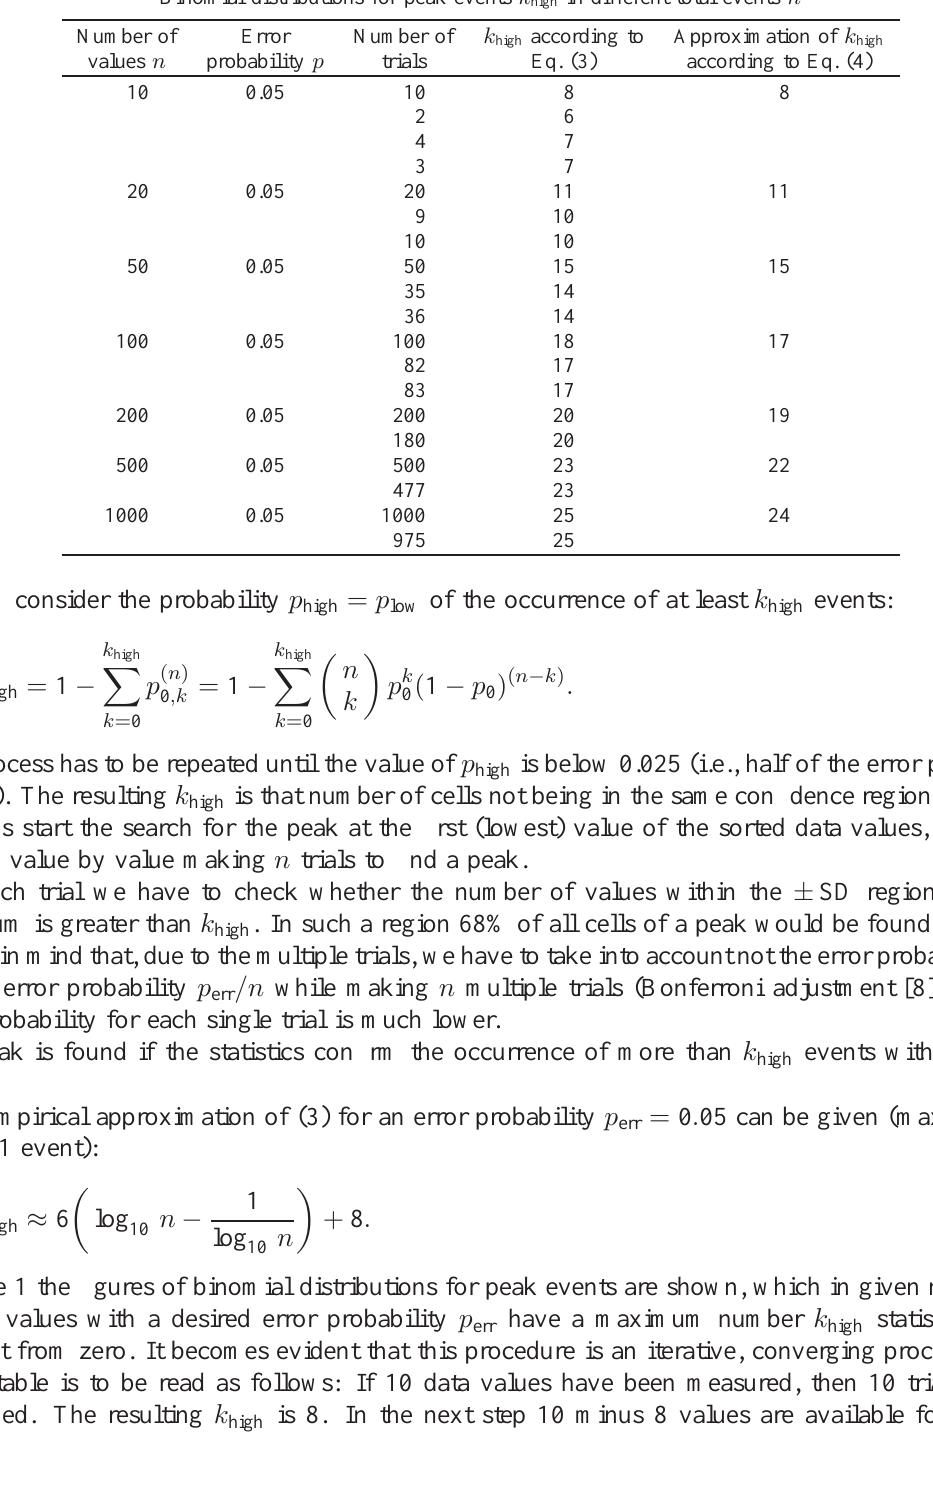
Table 1 Binomial distributions for peak events k high in different total events